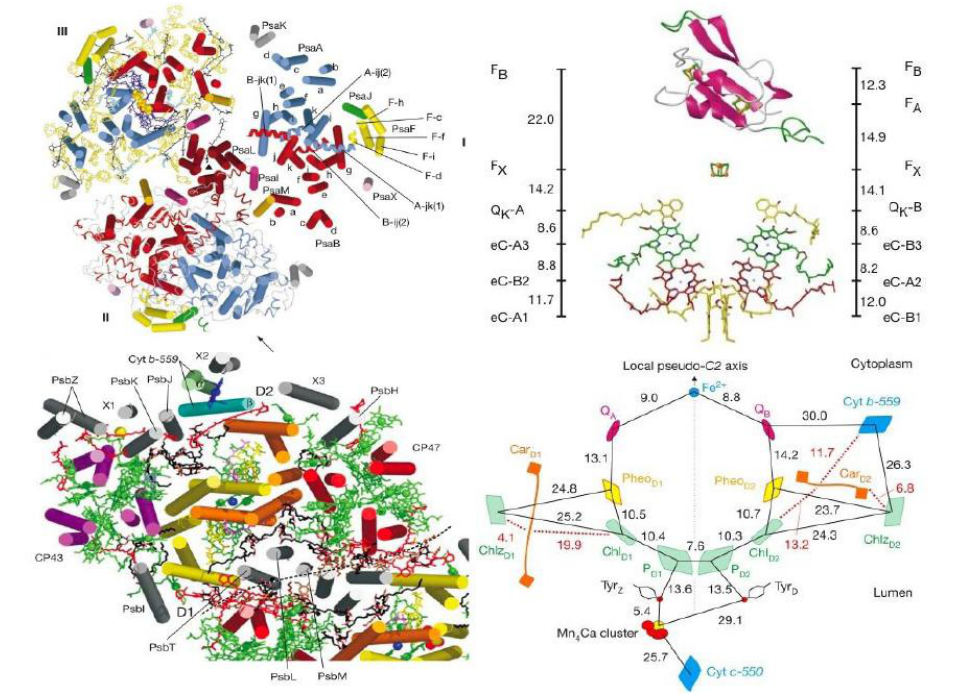
Figure 3. Structures and arrangement of cofactors in PS I (upper) [46] and PS II (lower) (Reproduced with permission from Nature publishing Group